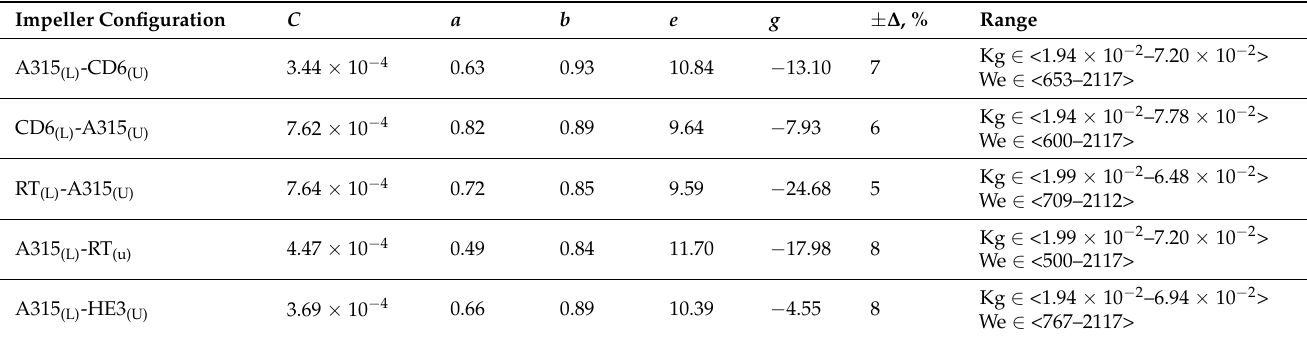
Table 2. Values of coefficients C, g and exponents a , b and e in Equation (5), the average relative error and ranges of gas flow number Kg, Weber number